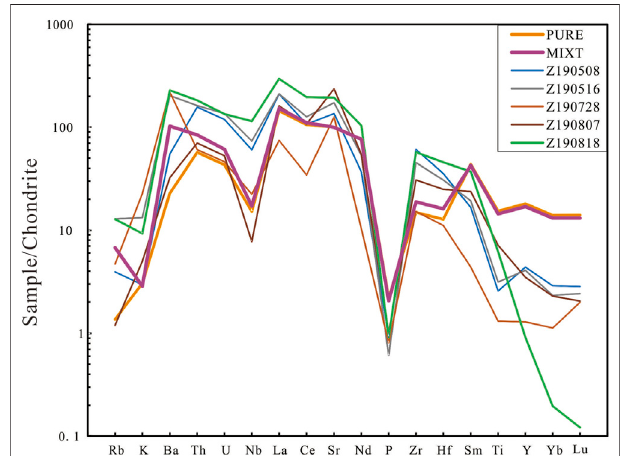
FIGURE 6 | Chondrite-normalized spidergram for the partial melts. C1- Chondrite data are from Sun and Mcdonough (1989), Z190728, Z190818, Z190516, Z190708, and Z190508, partial melts in runs from our experiment; PURE and MIXT, our starting